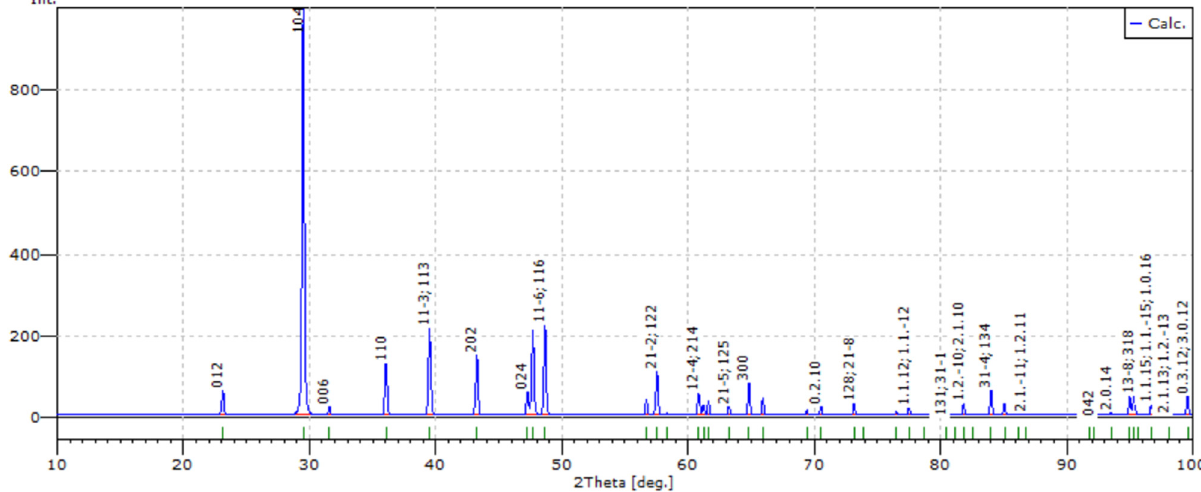
Figure 6: Numerically simulated di ff ractogram of deposited precipitate stored for 3 days.